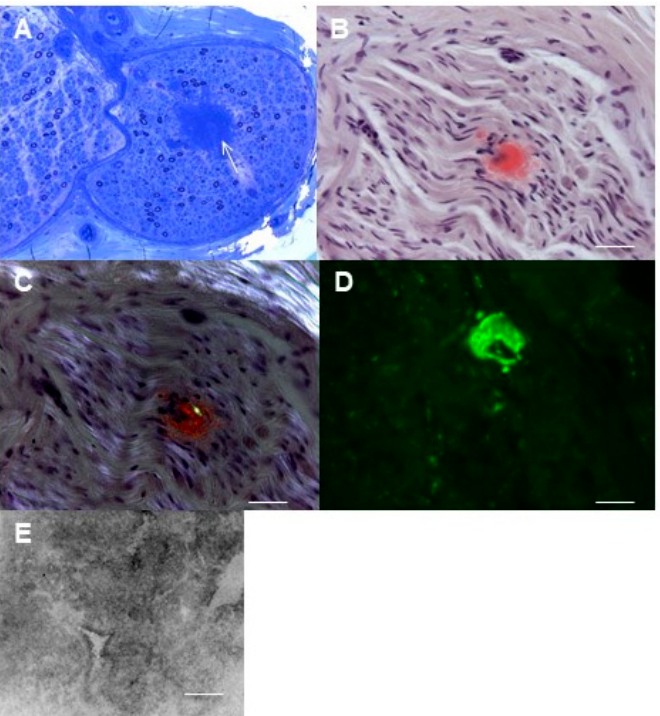
Figure 4. Sural nerve biopsy from patients with light chain amyloidosis (AL). ( A ) Axonal neuropathy with loss of myelinated nerve fibers and endoneurial perivascular accumulation of amorphous material (arrow) is observed (semithin section, toluidine blue, original magnification 20×; bar 100 mm). ( B ) Congo-red staining shows amyloid deposits in nerve fascicles ( B ), green birefringency is characteristically observed on cross polarizing filters ( C ) (paraffin section, original magnification 40×; bar 50 mm). ( D ) Direct immunofluorescence on frozen sections shows perivascular deposits of light chains (original magnification 40×; bar 50 μ m). ( E ) Electron micrograph of endoneurial amyloid deposit composed of a dense aggregate of straight fibrils (original magnification 7000×, bar 1 μ m).